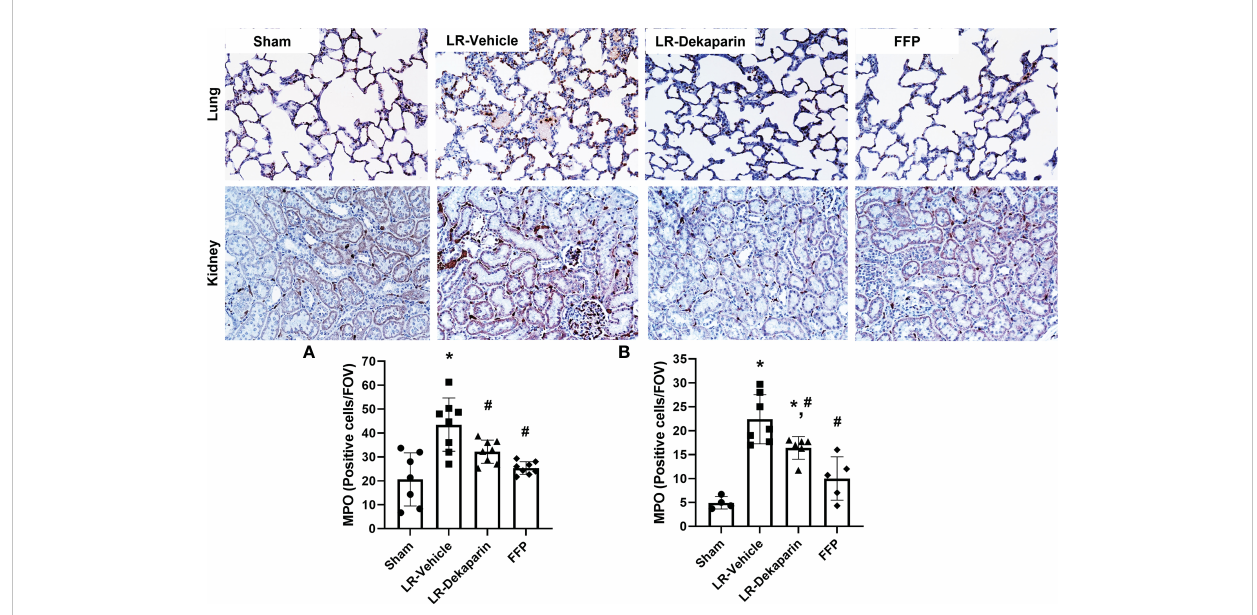
FIGURE 5 Dekaparin reduces organ neutrophil recruitment after T/HS. Lung and kidney tissue were collected after 3HR for immunohistochemical staining with anti-myeloperoxidase (MPO) antibodies. Representative images (20x) are provided for lung (top) and kidney (bottom). Three random images were collected of the (A) lungs and (B) cortex region of kidneys for quantifying the number of MPO-positive cells per fi eld of view by a technician blinded to treatment group. Data are expressed as mean with standard deviation. For lungs, N=7 Sham, N=8 LR-vehicle, N=8 LR-dekaparin, N=8 FFP. For kidneys, N=3 Sham, N=7 LR-vehicle, N=6 LR-Dekaparin, N=5 FFP. * denotes p<0.05 compared to sham. # denotes p<0.05 compared to LR-vehicle. LR, Lactated Ringer's; FFP, fresh frozen plasma; T/HS, trauma and hemorrhagic shock; 3HR, 3 hours after